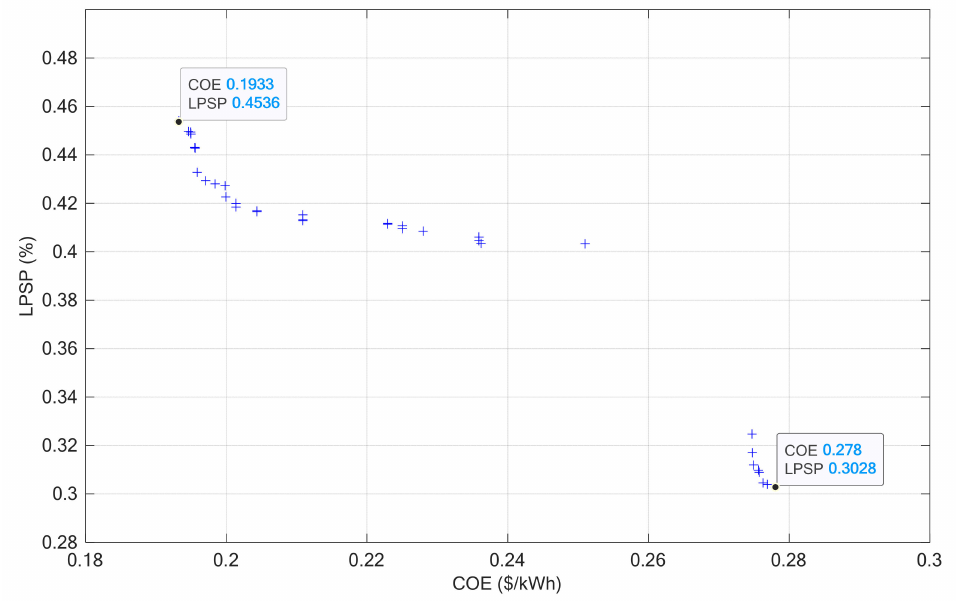
Figure 9. PF obtained for CASE 2 using